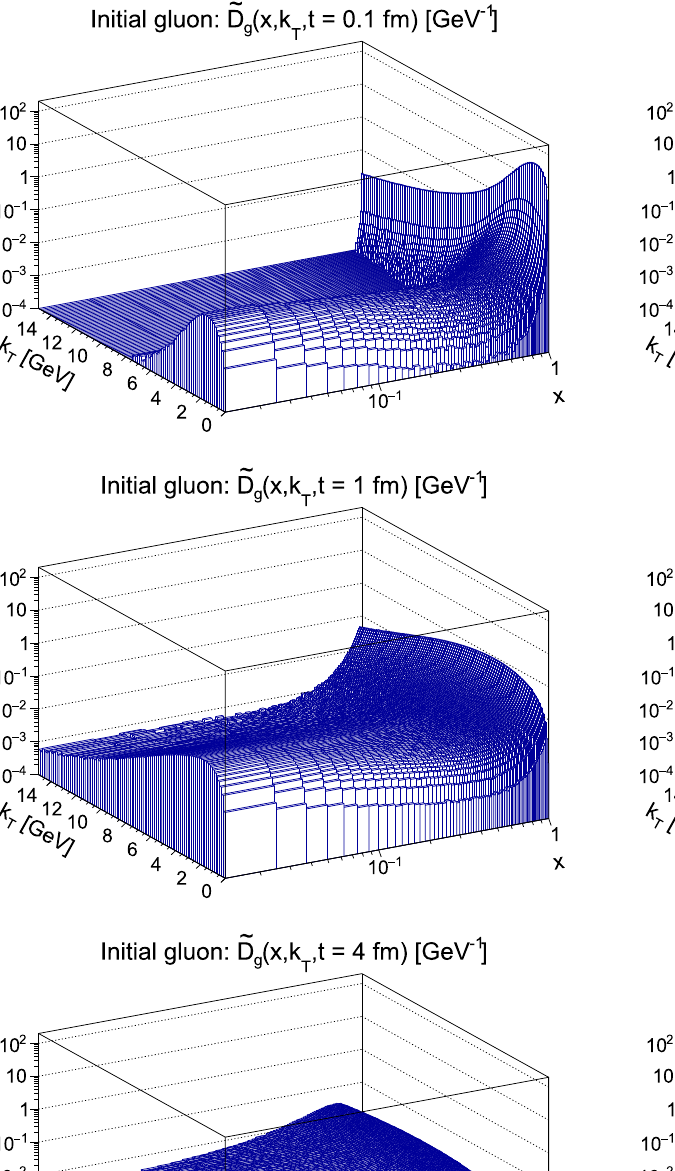
Fig. 5 The gluon (left) and quark (right) k T vs. x distributions for cascades initiated by gluons with w( l ) ∝ 1 / [ l 2 ( m 2 t = 0 . 1 , 1 ,